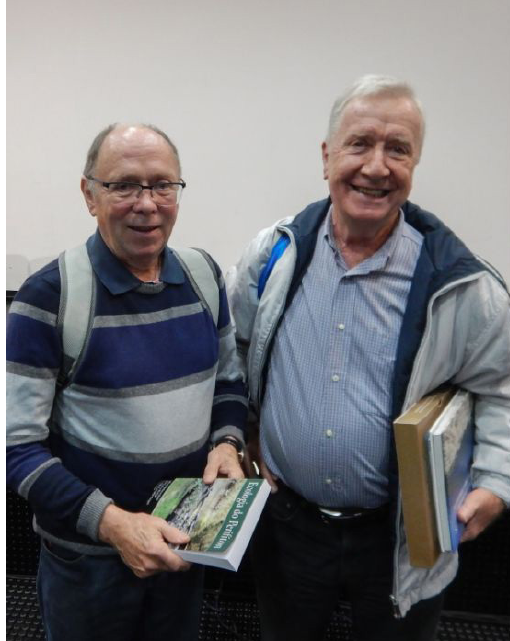
Figure 1. Albano Schwarzbold (right) and Alois Schäfer at the XV Brazilian Limnology Congress in Maringá 2015 (Photo: Alois Schäfer, personal archives).